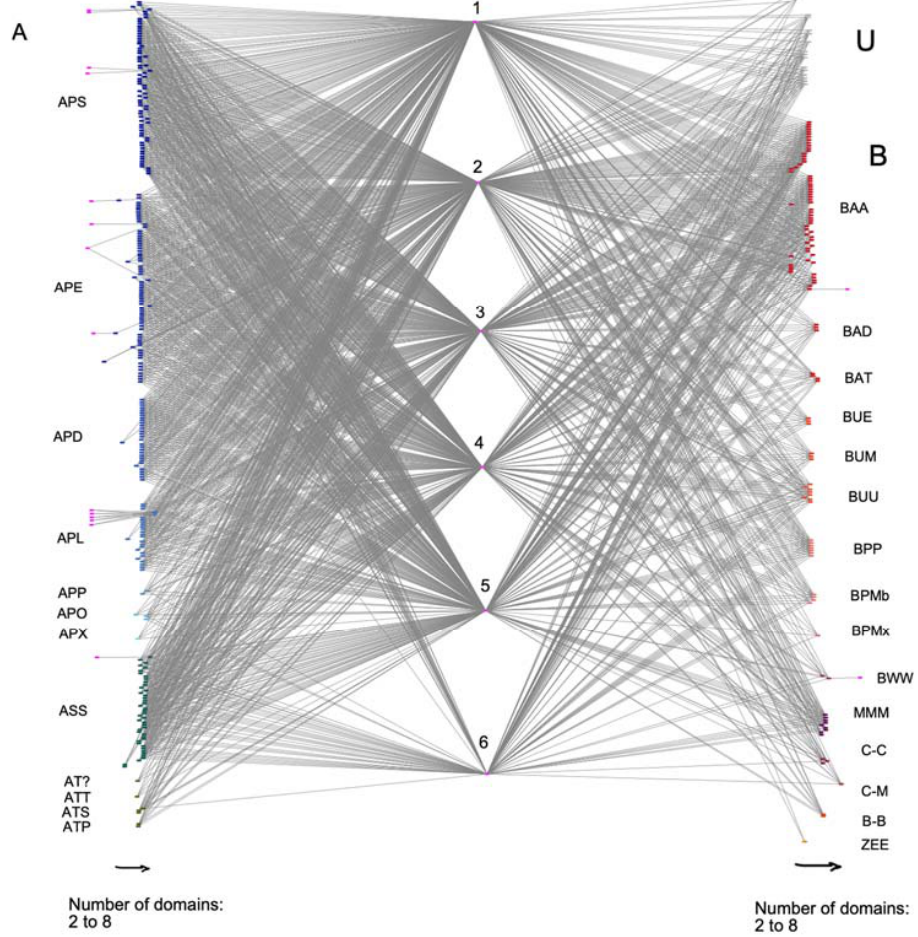
Figure 2. A bipartite network of EPSPS-associated domains in fungal species. Letters stand for different phylums and classes of fungi. On the left side, there are fungi of the phylum ascomycota (A), and on the right side, there are fungi of phylum Basidiomycota (B), Mucoromycota (M), Chytridiomycota (C), Blastocladiomycota (Bl), Zoopagomygota (Z), and Unknown taxa (U). Numbers correspond to fungal multi-domain: (1) DH synthase, (2) EPSP synthase, (3) SKI, (4) DHquinase_1, (5) Shikimate_dh_N, and (6) Shikimate_DH. Arrows on the bottom of the figure note the number of domains in the multi-domain, which ranges from two to eight domains. Subphylum and class starting from the upper left are Pezizomycotina: Sordariomycetes (APS), Eurotiomycetes (APE), Dothideomycetes (APD), Leotiomycetes (APL), Pezizomycetes (APP), Orbiliomycetes (APO), and Xylonomycetes (APX); Saccharomycotina: Saccharomycetes (ASS); Taphrinomycotina: incertae sedis (AT?), Taphrinomycetes (ATT), Schizosaccharomycetes (ATS), and Pneumocystidomycetes (ATP); Agariomycotiina: Agaricomycetes (BAA), Dacrymycetes (BAD), and Tremellomycetes (BAT); Ustilaginomycotina: Exobasidiomycetes (BUE), Malasseziomycetes (BUM), and Ustilaginomycetes (BUU); Pucciniomycotina: Pucciniomycetes (BPP), Microbotryomycetes (BPMb), and Mixiomycetes (BPMx); Wallemiomycotina: Wallemiomycetes (BWW); Mucoromycotina: Mucoromycetes (MMM); Chytridiomycota: Chytridiomycetes (C-C) and Monoblepharidomycetes (C-M); Blastocladiomycota: Blastocladiomycetes (BI-B) and Entomophthoromycotina: Entomophthoromycetes (ZEE).